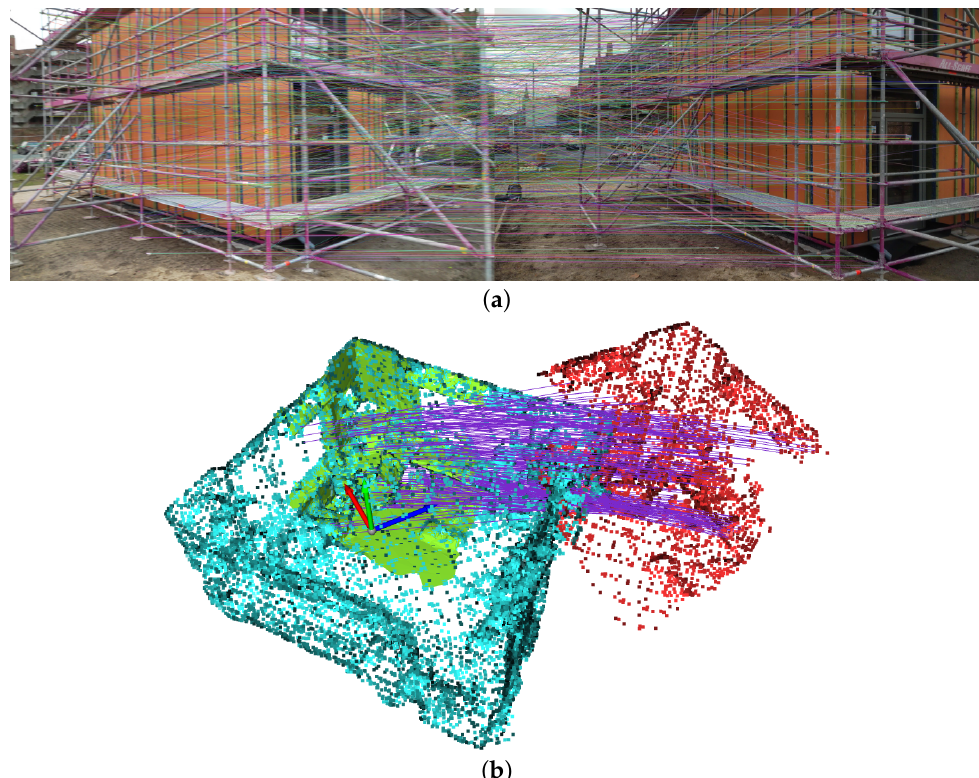
Figure 5. Overview of the feature matches between different data types. ( a ) Example of the epipolar lines of the ORB feature matches between two images with (green) successful matches and (red) erroneous matches. ( b ) Example of the successful FPFH [37] feature matches (lines) between points clouds captured in consecutive XR